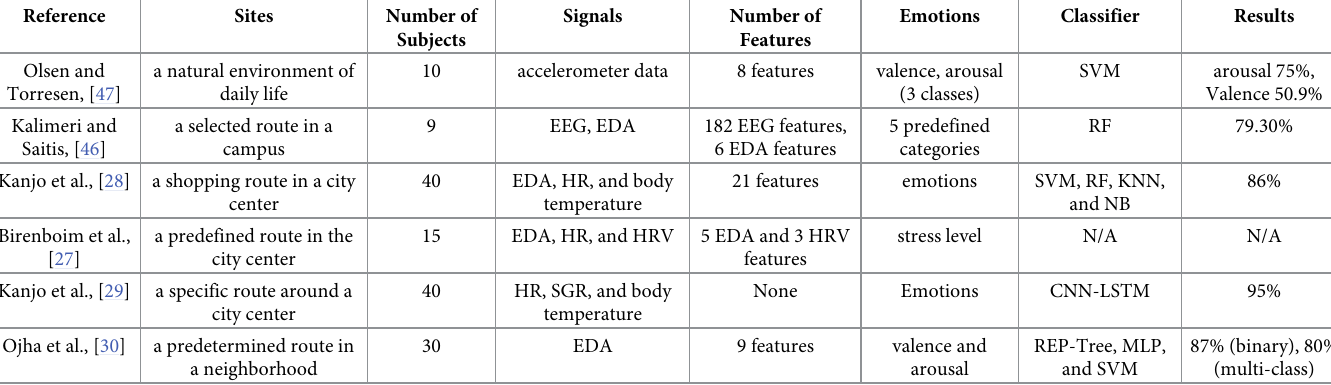
Table 1. Related studies on emotion recognition using physiological sensors in urban spaces over the decade.